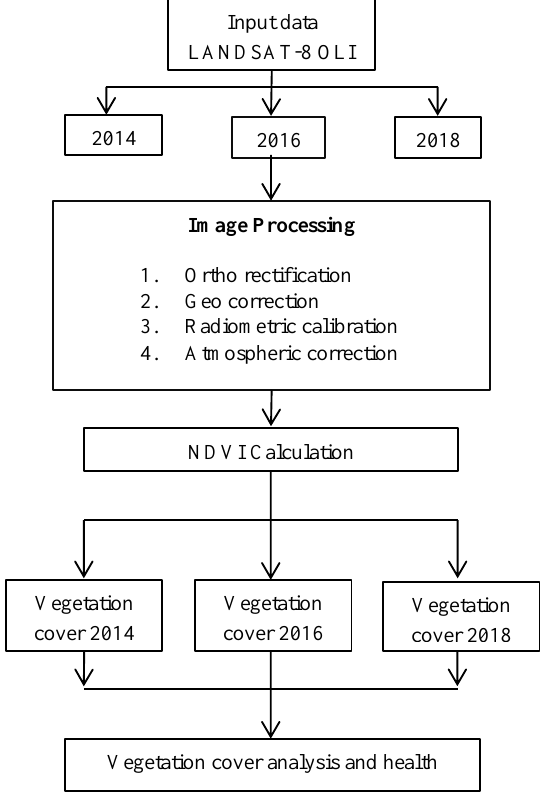
Fig. 3: NDVI map of the damaged area in May 2014, 2016 Fig. 2: Methodology for the analysis of vegetation health (NDVI)